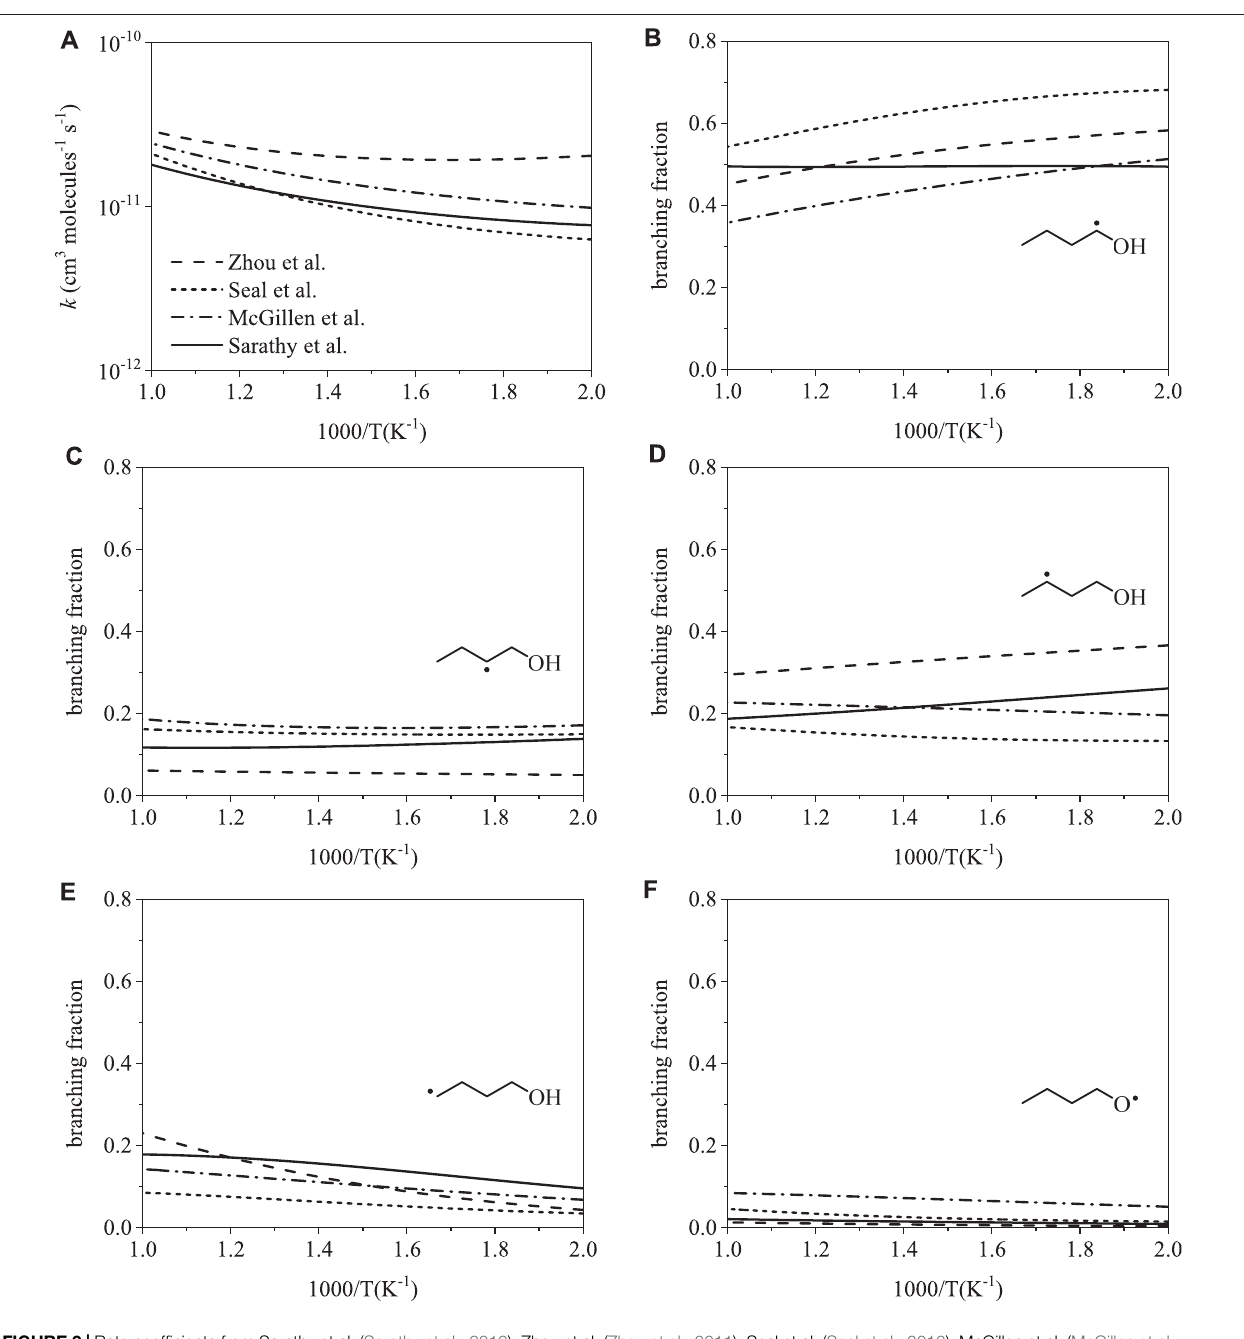
Frontiers in Mechanical Engineering |